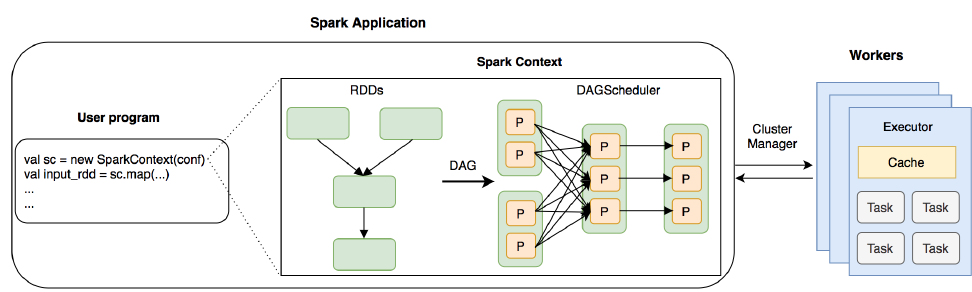
Figure 3. Deploying computation in Spark.